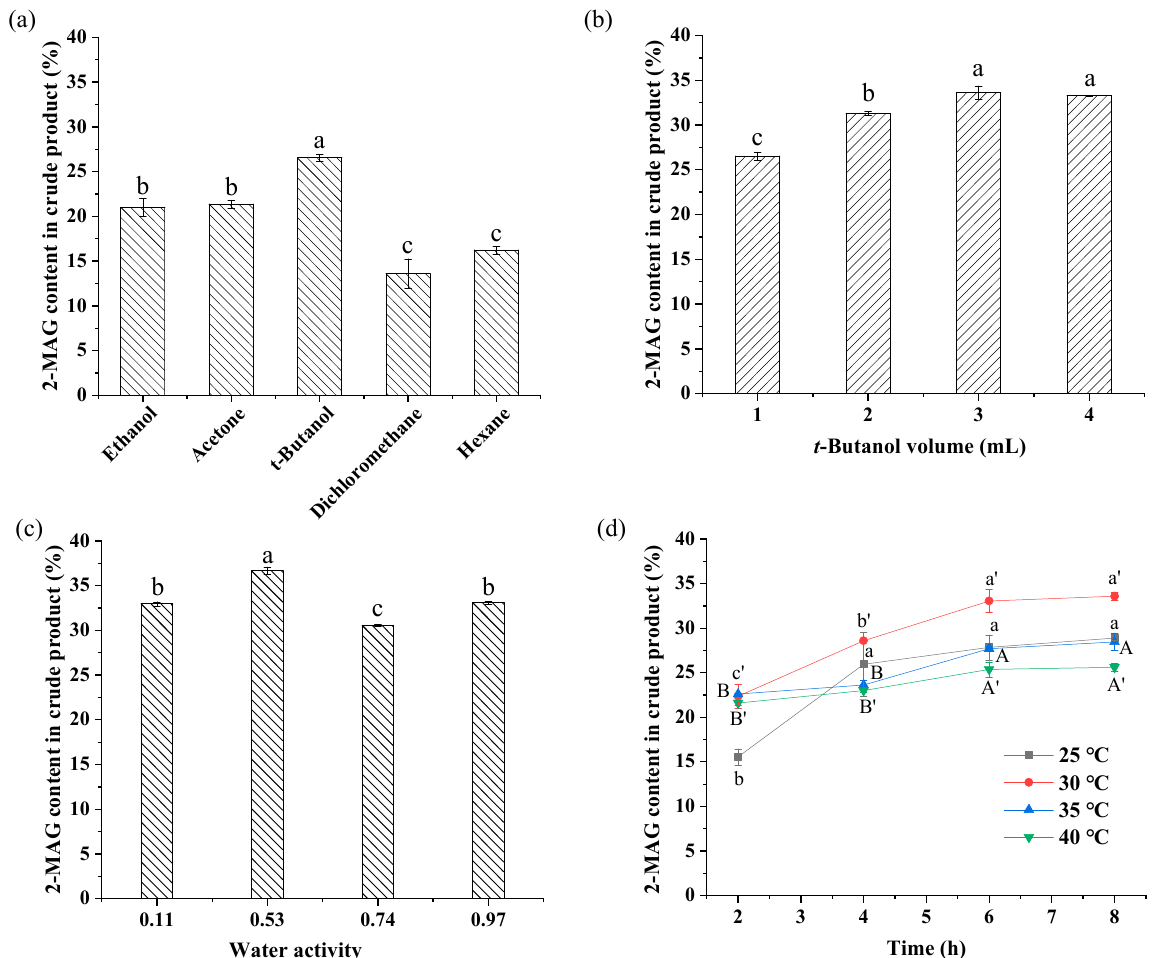
Figure 2. Optimization of rea ction conditions of enzymatic alcoholysis. Reaction conditions: ( a ) molar ratio of 1:40 (fungal oil/ethanol), 15% (relative to the mass of oil) Lipozyme TL IM, solvent volume of 1 mL, a w of 0.53, 35 °C, 8 h. ( b ) molar ratio of 1:40 (fungal oil/ethanol), 15% (relative to the mass of oil) Lipozyme TL IM, t -butanol as solvent, a w of 0.53, 35 °C, 8 h. ( c ) molar ratio of 1:40 (fungal oil/ethanol), 15% (relative to the mass of oil) Lipozyme TL IM, 3 mL t -butanol as solvent, 35 °C, 8 h. ( d ) molar ratio of 1:40 (fungal oil/ethanol), 15% (relative to the mass of oil) Lipozyme TL IM, 3 mL t -butanol as solvent, a w of 0.53. Different letters in the figure indicated significant differences at the p < 0.05 level.